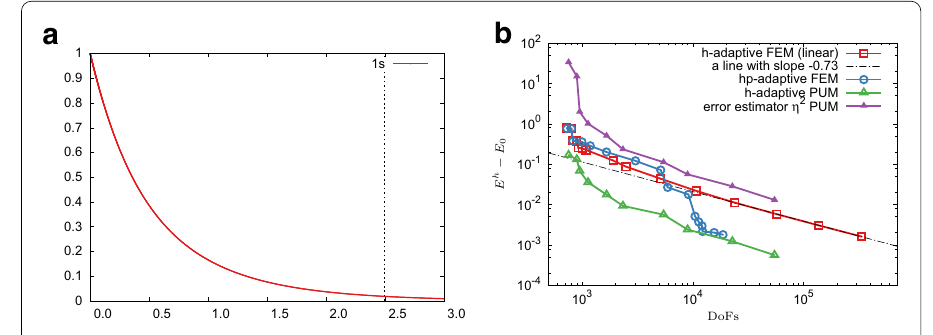
Fig. 5 Finite element solution of He atom. a Scaled radial solution. The dotted vertical line indicates the enrichment radius. b Convergence of the error in total energy of He atom for various FE methods